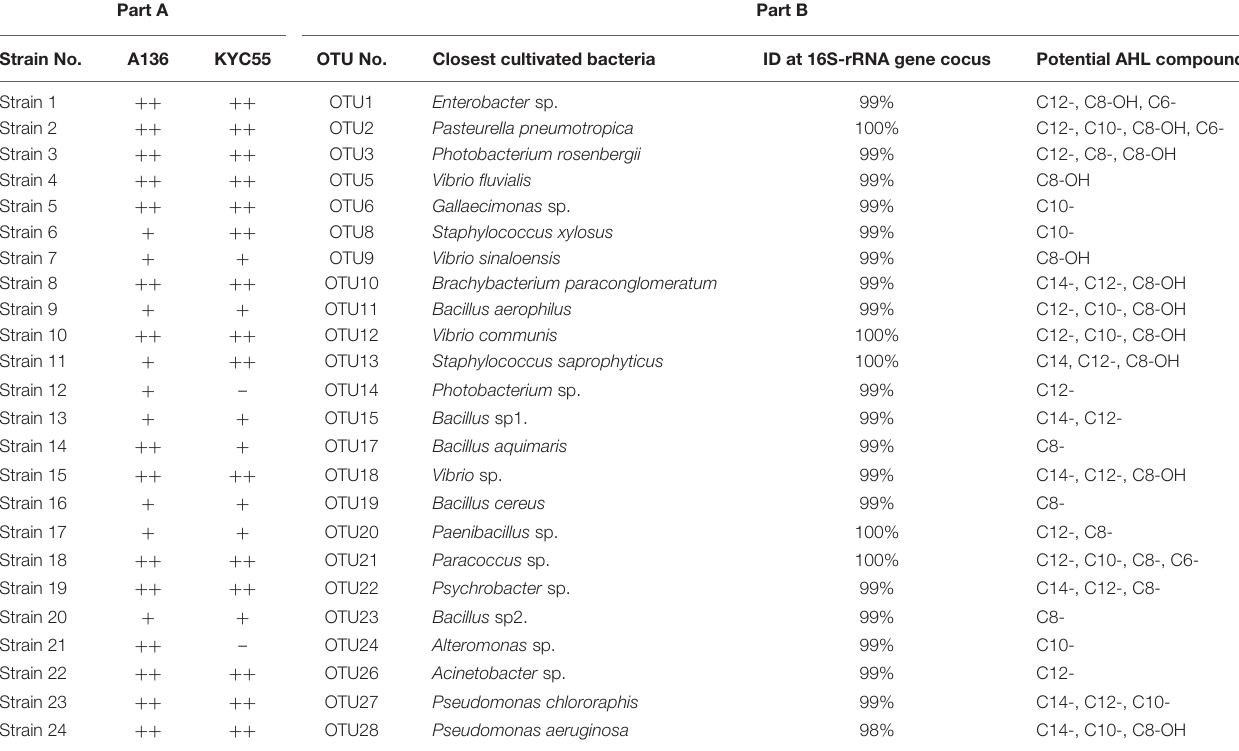
TABLE 1 | N -acyl-homoserine lactone (AHL) profiling of 24 representative rhizobacteria isolated from the mangrove rhizosphere environment. Part A Part B Strain